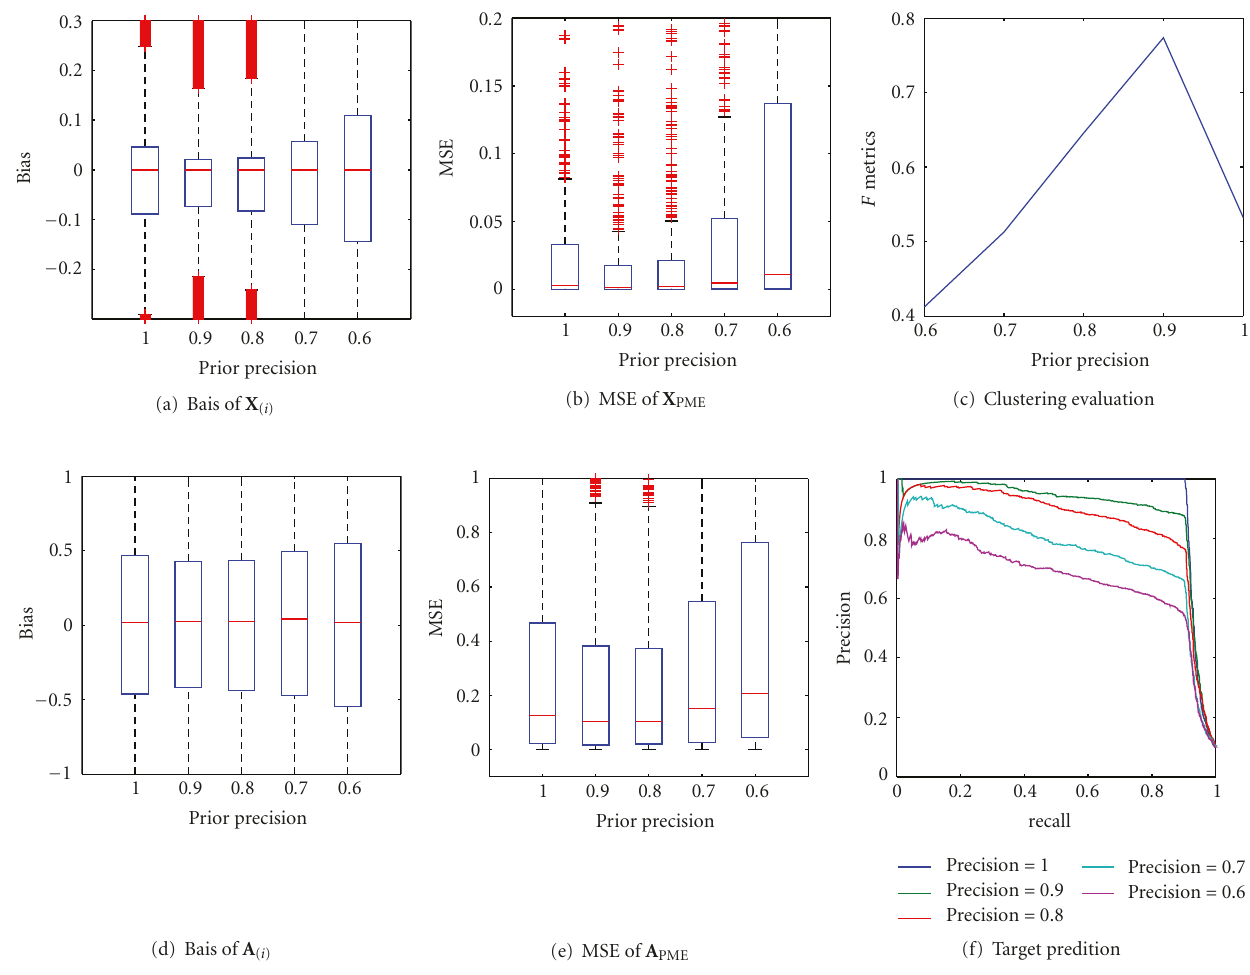
Figure 6: Performance of BSCRFA when precision of prior knowledge is di ff